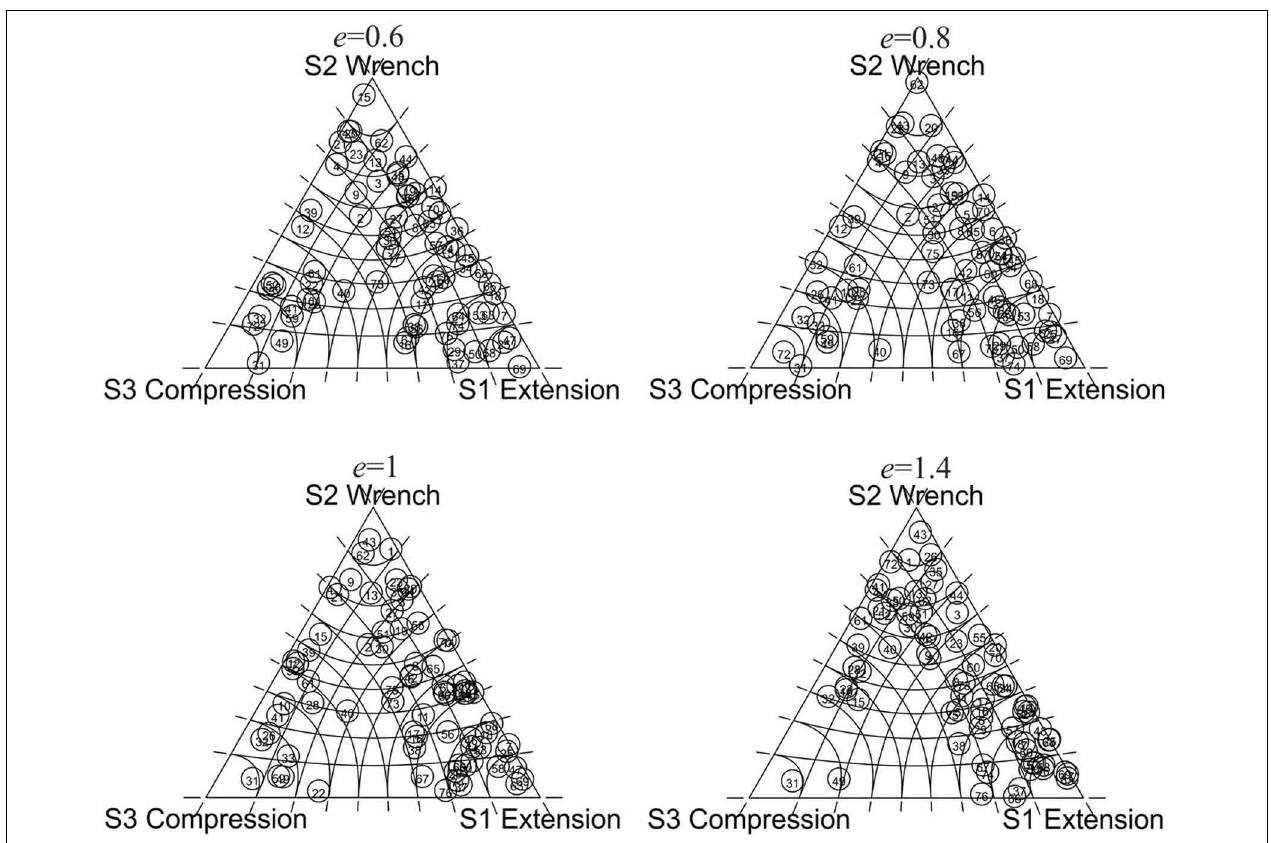
FIGURE 5 | Ternary diagrams of the principal stress axes of the reduced stress tensors for the different damped stress fields. The damping parameter e is indicated above each diagram.